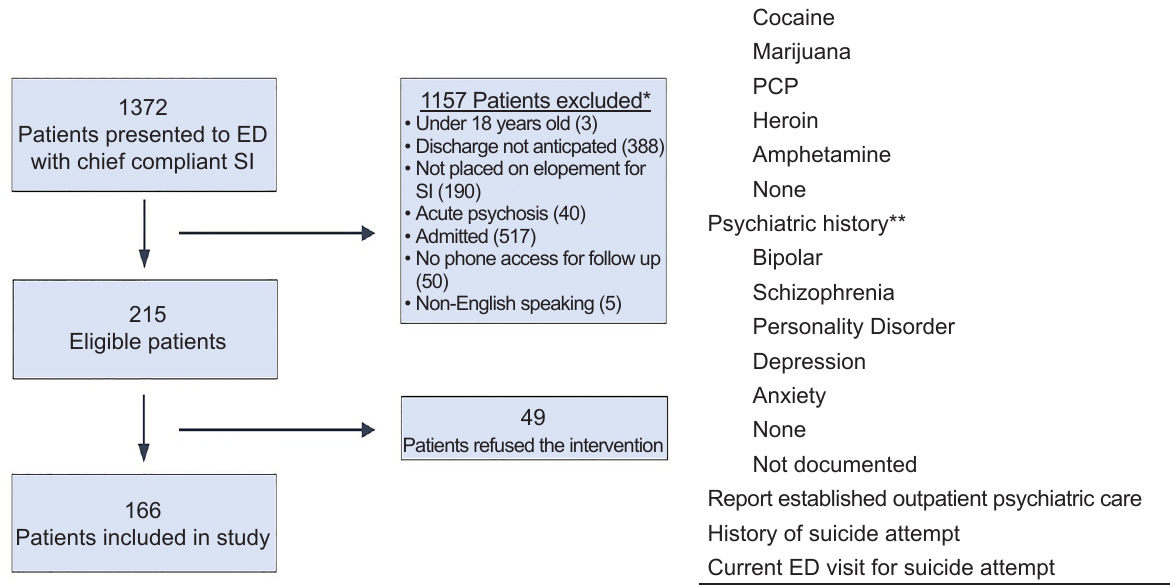
Figure 1. Cohort inclusion matrix of 1,372 patients who